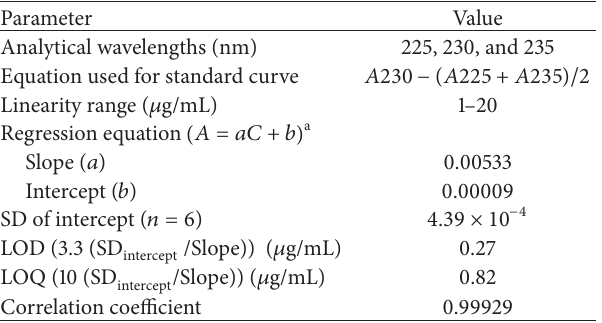
Table 1: Analytical parameters for determination of GLIP using the